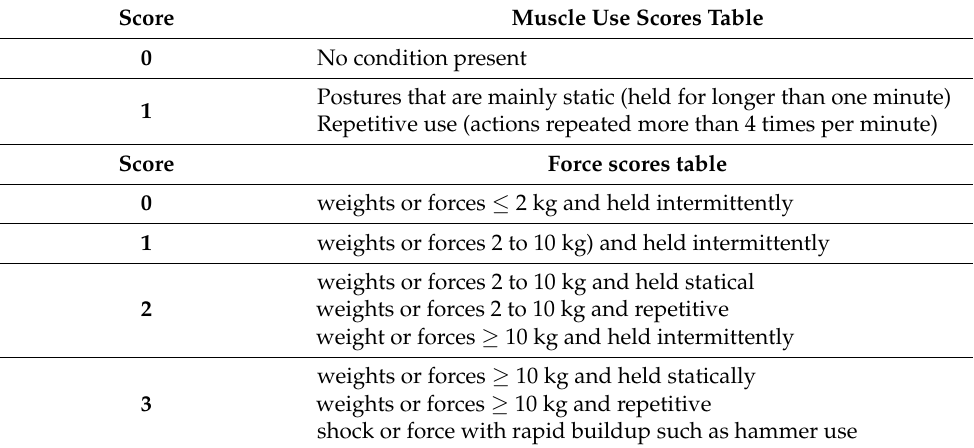
weights or forces 2 to 10 kg and repetitive weight or forces ≥ 10 kg and held intermittently weights or forces ≥ 10 kg and held statically weights or forces ≥ 10 kg and repetitive shock or force with rapid buildup such as hammer use